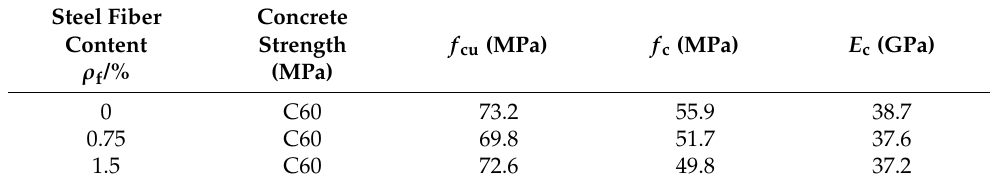
Table 3. Material properties of steel fiber concrete.